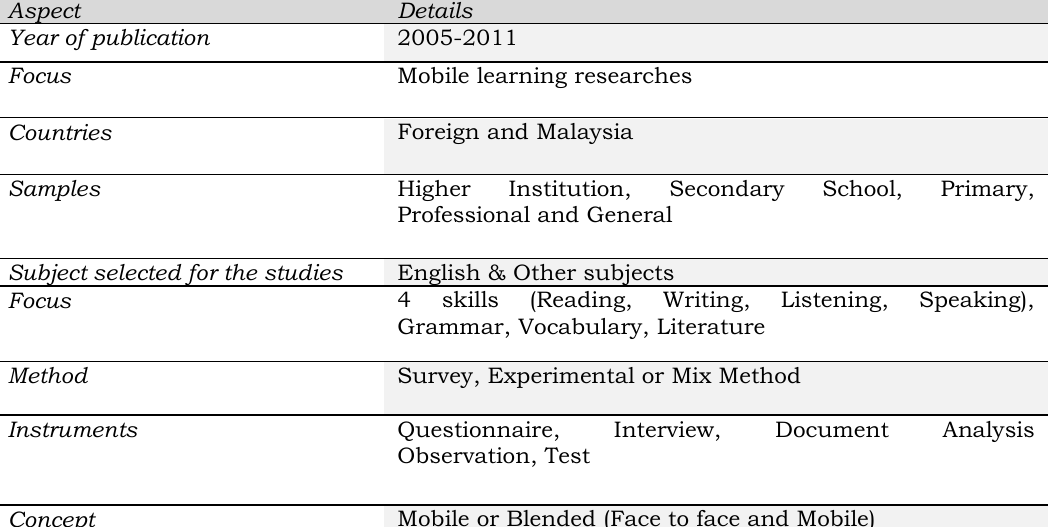
Table 1. The Summary of the Reviewed